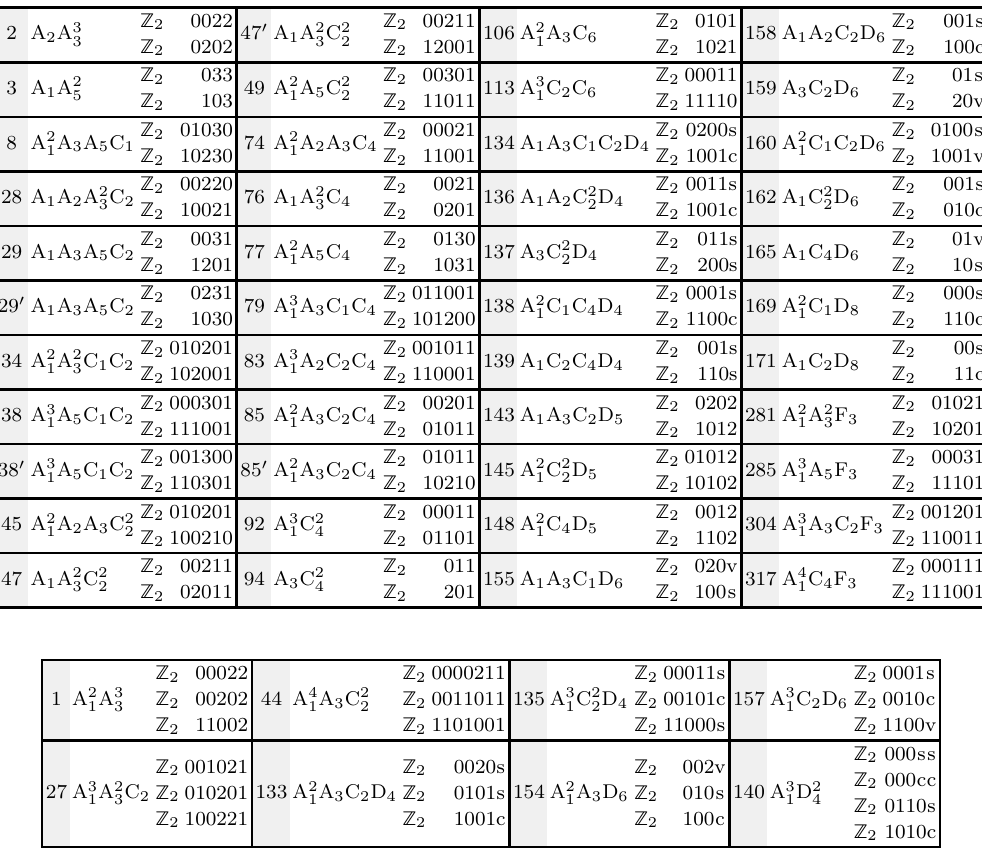
Table 10 . Groups of maximal rank with non-trivial fundamental group and their generators for the heterotic Z 2 triple.